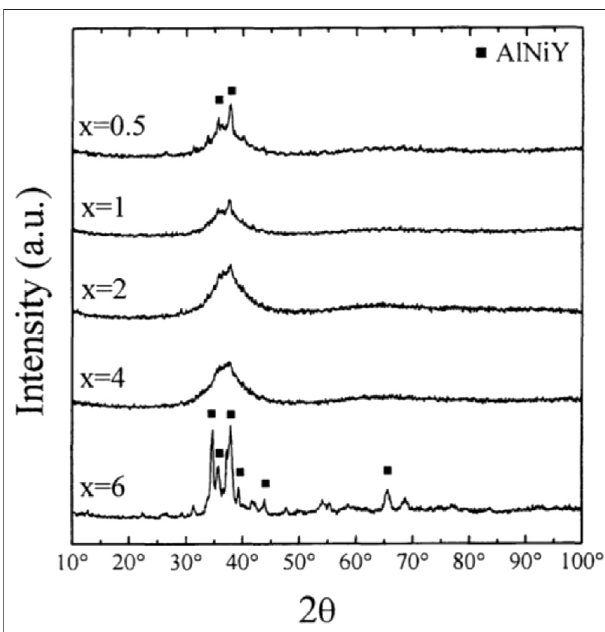
FIGURE 4 | XRD patterns of the (Zr 65 Al 85 Ni 10 Cu 20 ) 100-x Y x . © 2000 The Japan Institute of Metals (Yong et al., 2000).